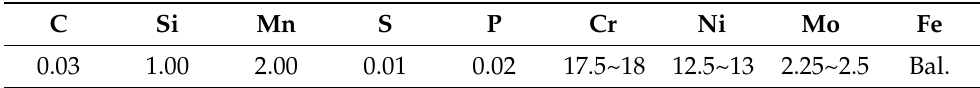
Table 1. Chemical composition of 316L stainless steel powder.